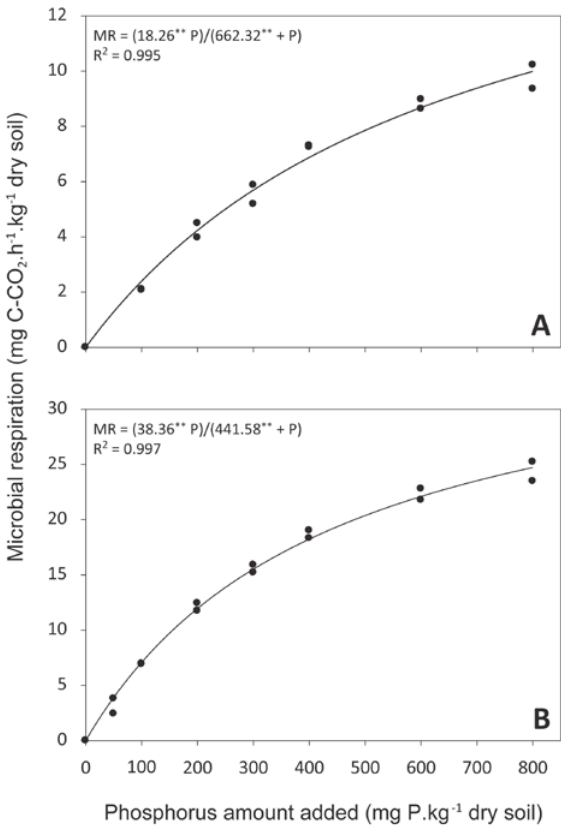
Fig. 3 - Microbial respiration in response to phosphorus addition in soils. The soil samples are represented with NT ( A ) and CT ( B ). The signs (**) show that kinetic parameters to the Michaelis- Menten are significantly fitted at a probability level of 5% (N=2).